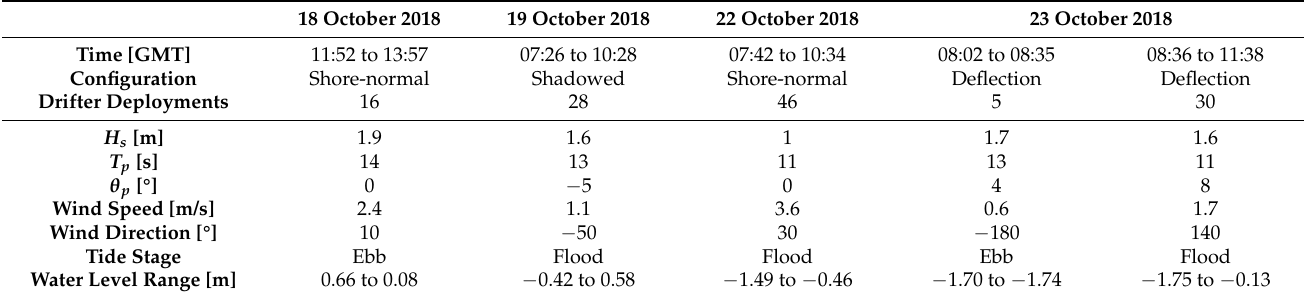
Table 1. Field conditions during the four days of drifter deployments. Offshore peak wave angle of incidence ( θ p ) and wind direction incidence are relative to the shore